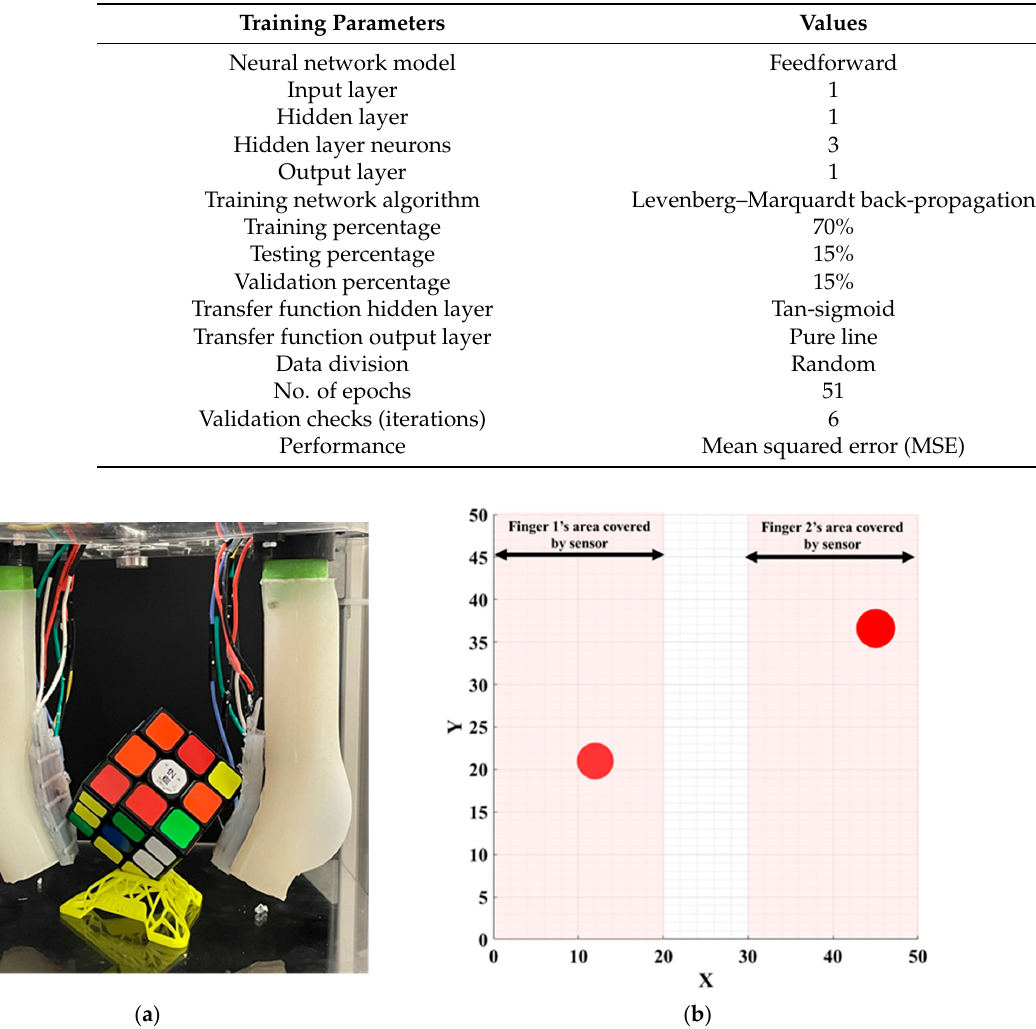
Table 3. Specifications and parameters of the ANN model.